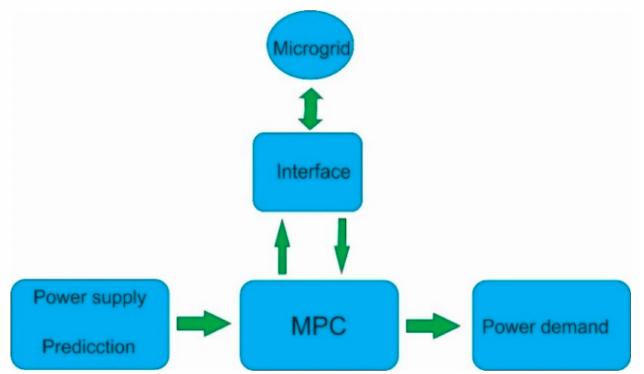
Figure 4. The structure of an EMS (Correct prediction, square on the